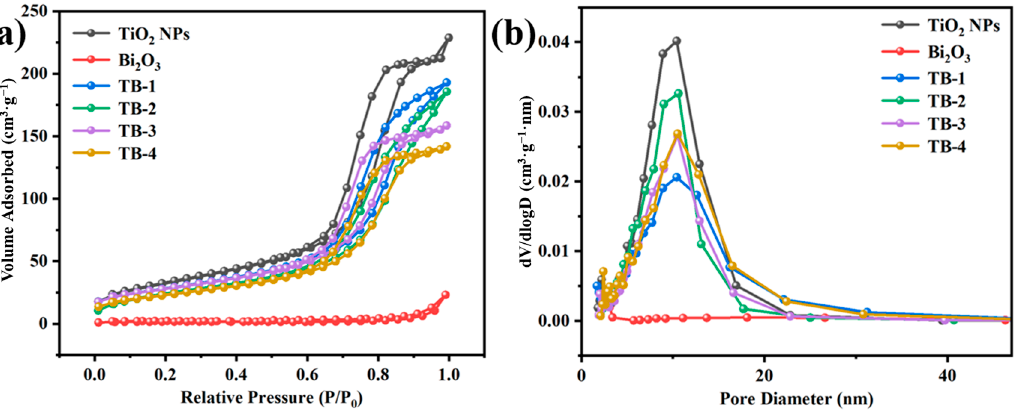
Figure 5. ( a ) N 2 absorption–desorption isotherms, ( b ) corresponding pore size distributions of the TiO 2 NPs, Bi 2 O 3 , and TB-x (x =